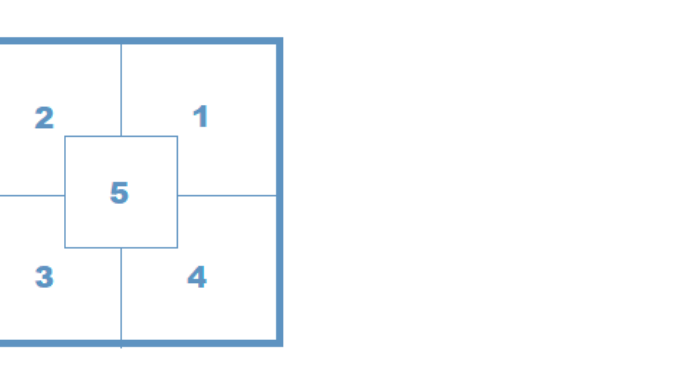
Figure 5. Scheme for the electrical resistance measurement of the embroidered element: starting in zone 1 and finishing in zone 5.